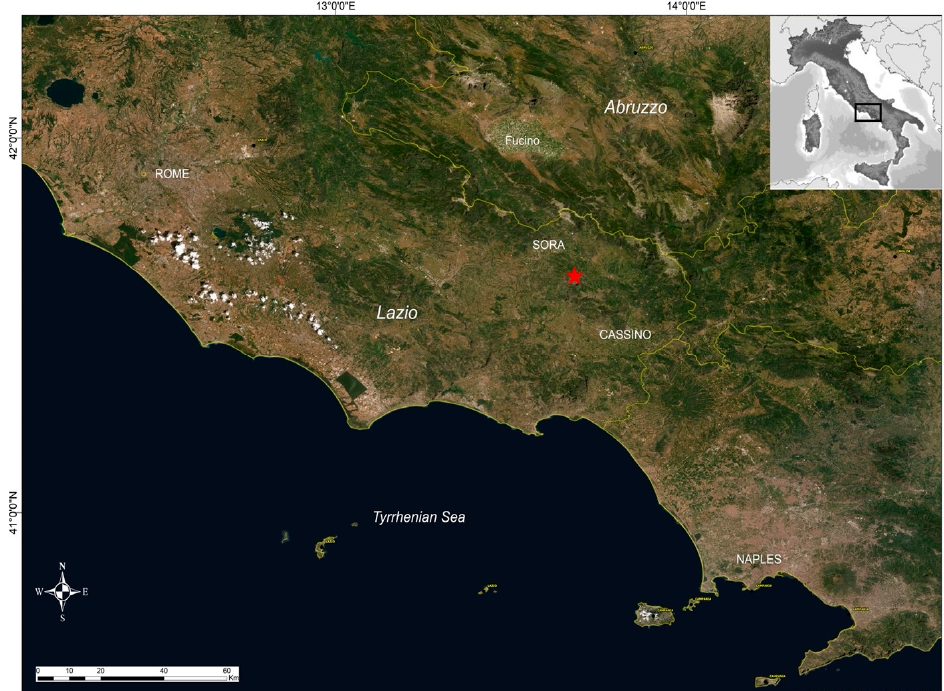
Figure 1. Epicentral location of the 1654 earthquake (red star). The cities of Rome and Naples are less than 100 km of distance from the source.